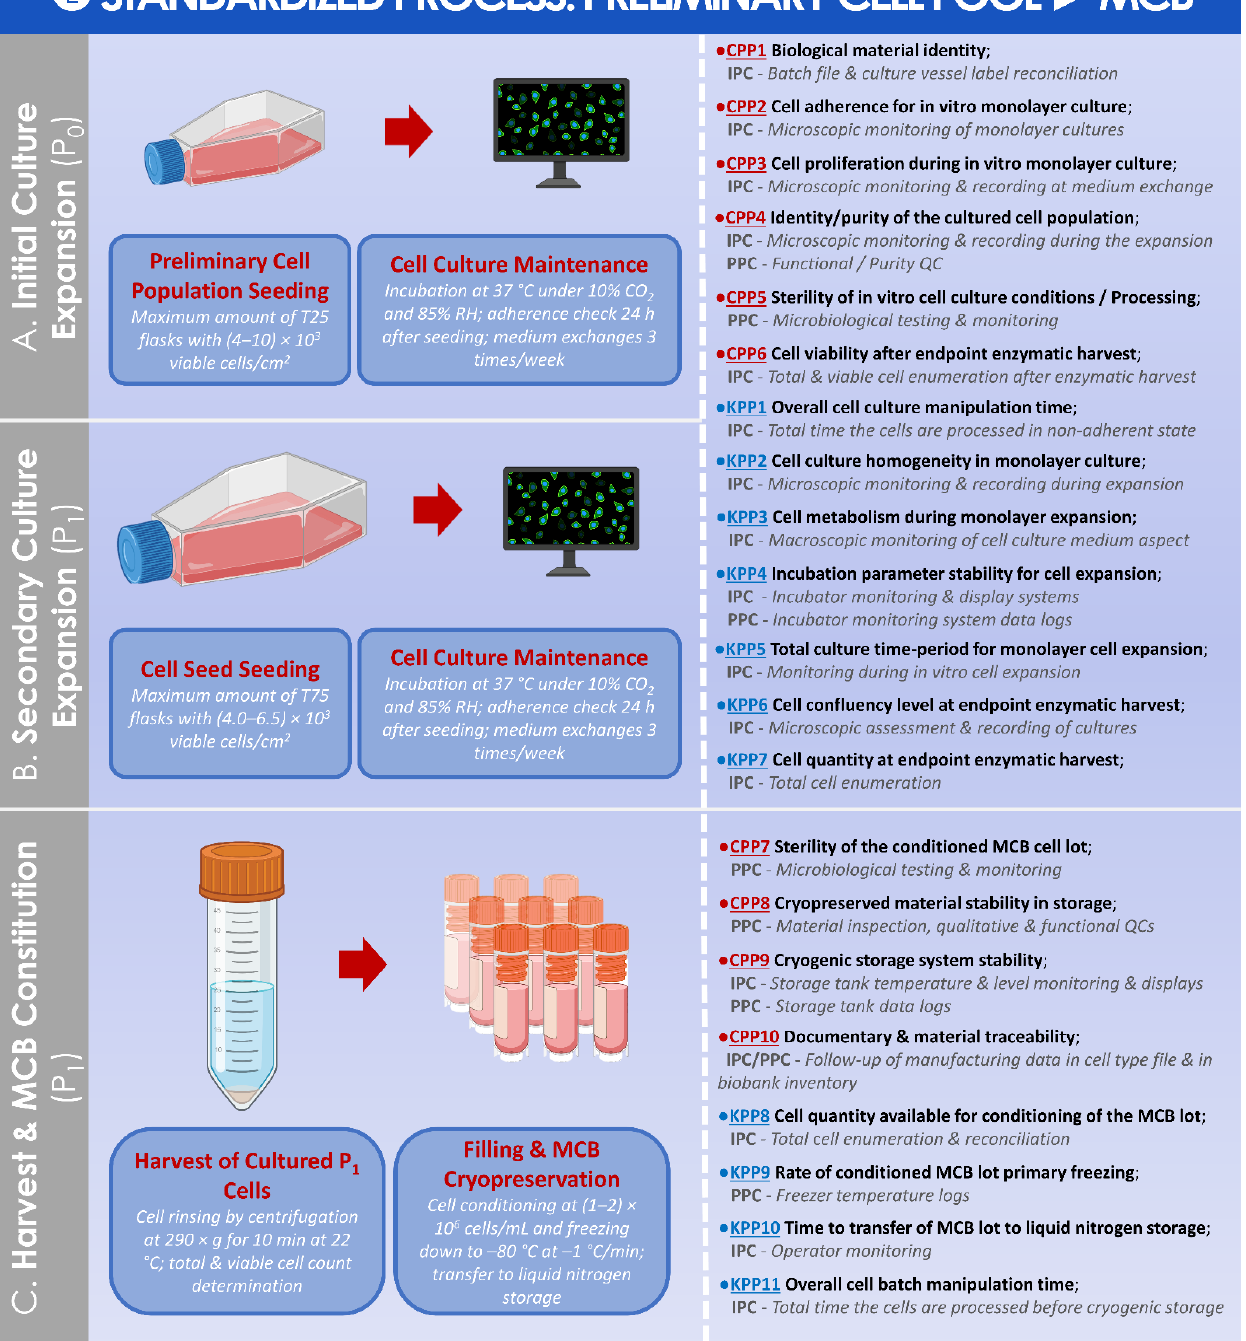
supplementary document – Process Parameters: Table PP1. API, active pharmaceutical ingredient; CPP, critical process parameter; HAC, human articular chondrocytes; IPC, in-process control; KPP,